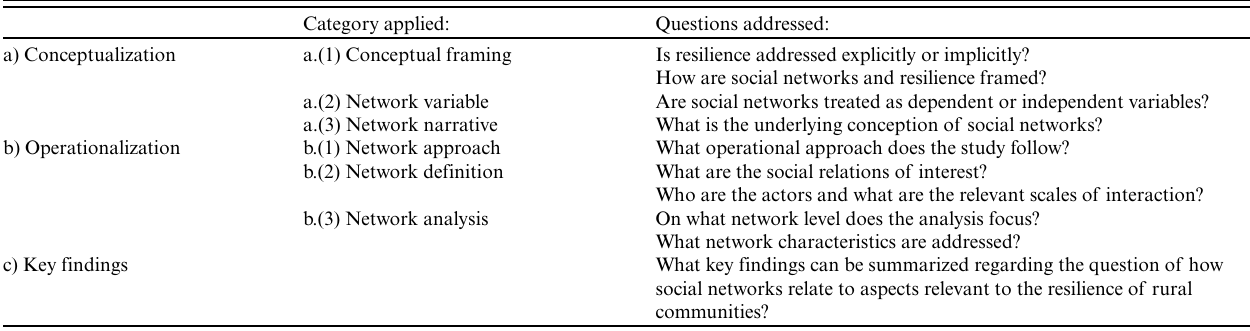
Table 1 . Categories applied for the literature